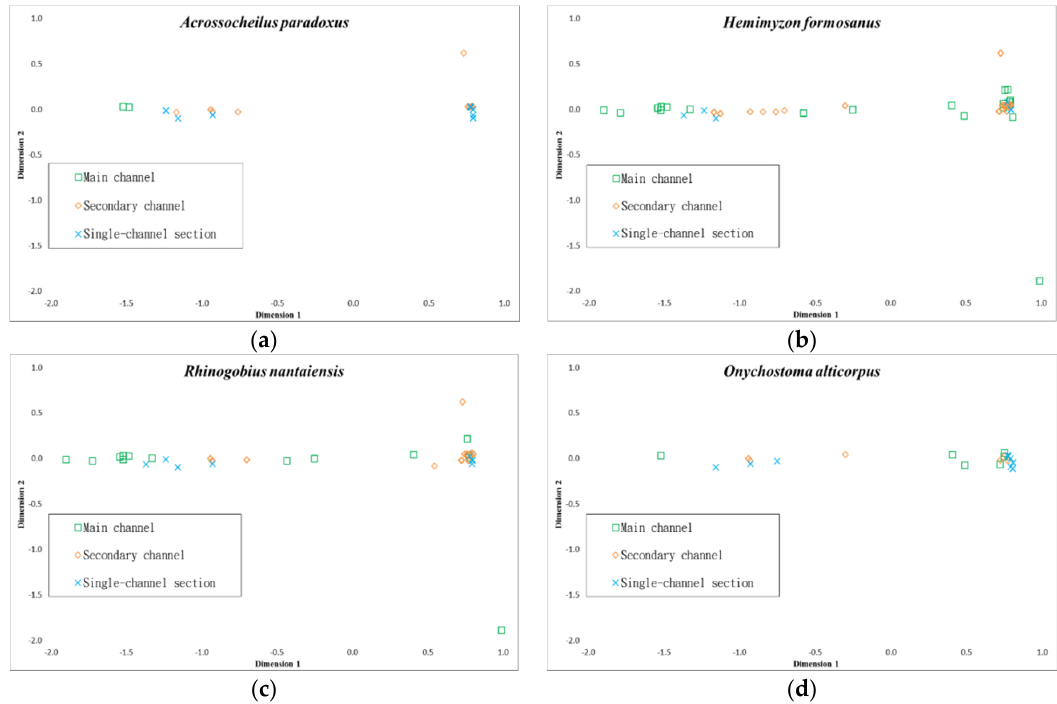
Figure 2. The plots from the environmental data indicating fish habitats as shown in the nMDS diagram. The stress value is 0.01. ( a ) The differences in habitat characterization of Acrossocheilus paradoxus in the multiple- and single-channel sections; ( b ) The differences in habitat characterization of Hemimyzon formosanus in the multiple- and single-channel sections; ( c ) The differences in habitat characterization of Rhinogobius nantaiensis in the multiple- and single-channel sections; ( d ) The differences in habitat characterization of Onychostoma alticorpus in the multiple- and single-channel